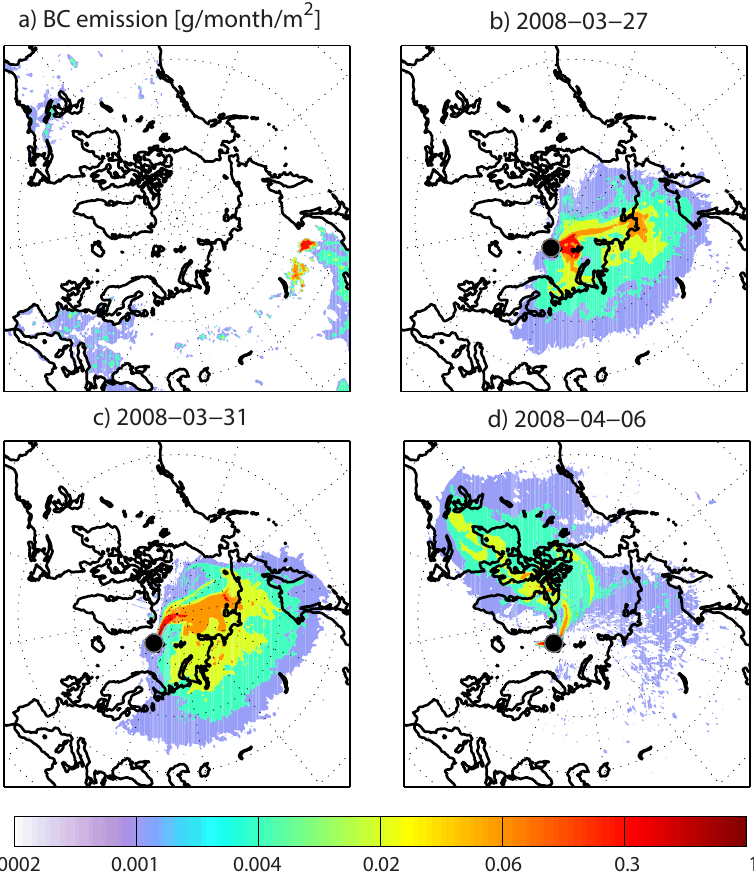
Figure 4. (a) shows the geographical distribution of the total emission flux of BC from GFED and GAINS biofuel emission for March 2008 [kgs − 1 ]. (b–d) shows the footprint sensitivities for the days 27 and 31 March and 6 April